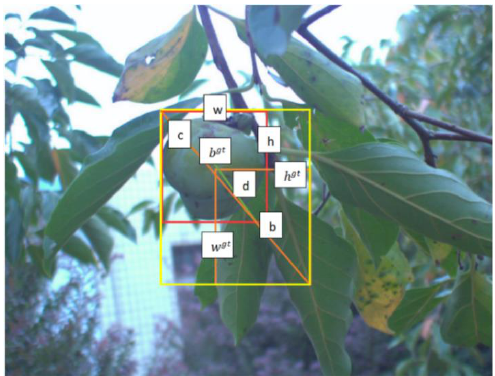
Figure 8. The structure of the CIoU_loss.